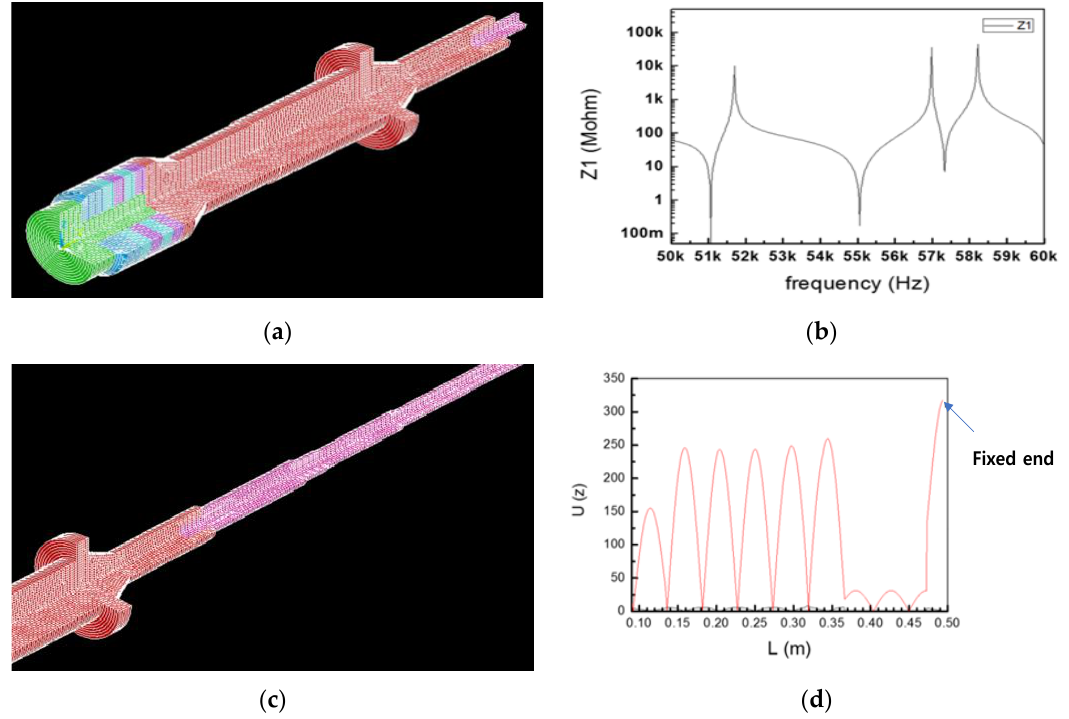
Figure13. ( a )ModelanalysisoftheBLUT.( b )Impedancevs. frequencygraphoftheBLUT.( c )displacement Figure 13. ( a ) Model analysis of the BLUT. ( b ) Impedance vs. frequency graph of the BLUT. ( c ) model and ( d ) data of BLUT combined with the waveguide 3D assembly displacement model and ( d ) data of BLUT combined with the waveguide 3D assembly model.